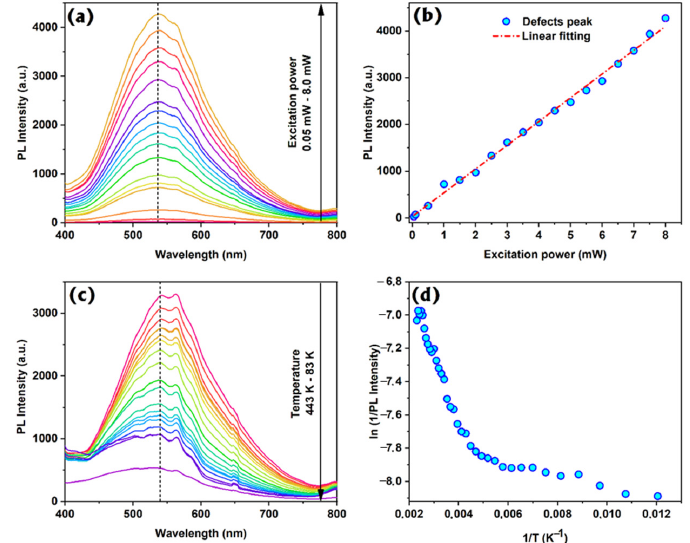
Figure 6. ( a ) PL power-dependence spectra and ( b ) the peak position vs. excitation power; ( c ) PL temperature dependence; and ( d ) logarithmic approximation for the PVDF/ZnO sample.